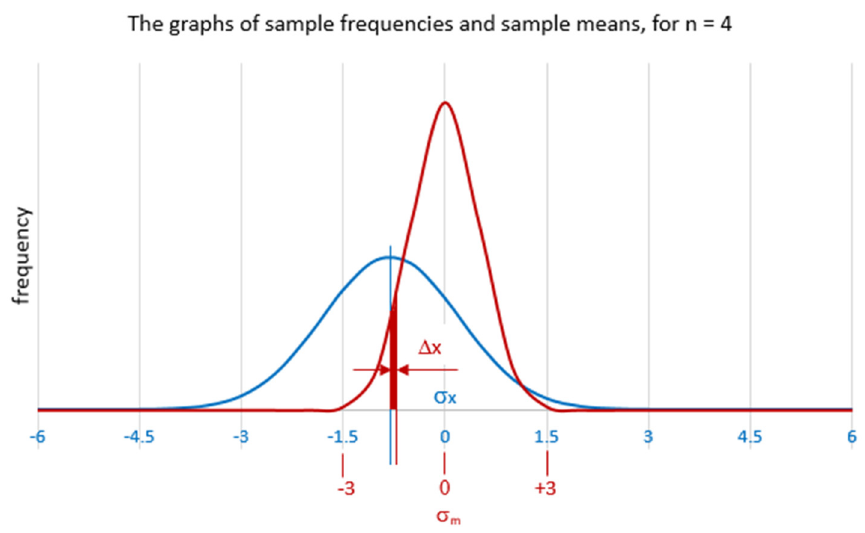
Figure 6. The distribution of the means and the distribution of the variable x for a certain value of the mean, for sample size n =